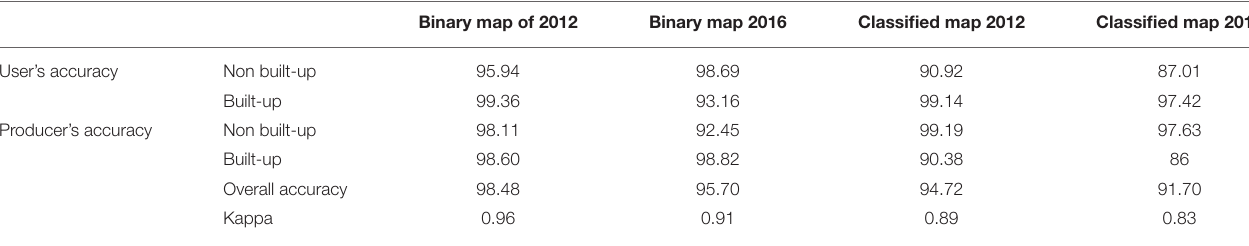
TABLE 4 | Accuracy assessment of binary maps and classified